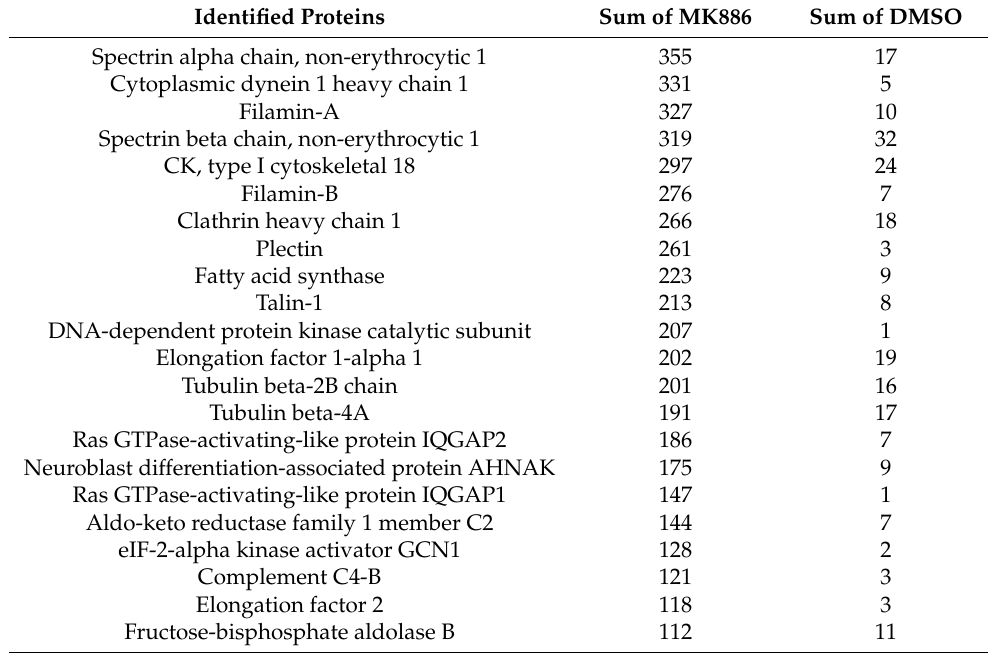
Table 1. Proteomics analysis of ECM fraction of donor 1 PHH spheroids treated with 100 µ M MK886 for 72 h. The 31 most highly expressed proteins in MK886 treatment that are >10-fold increased by the drug versus DMSO in the ECM fraction alone. A total of 2676 proteins were analysed. Data are from triplicate MK886/DMSO ECM fractions. ‘Sum of MK886 (cid:48) or ‘Sum of DMSO’ shows the total expression of a given protein in each